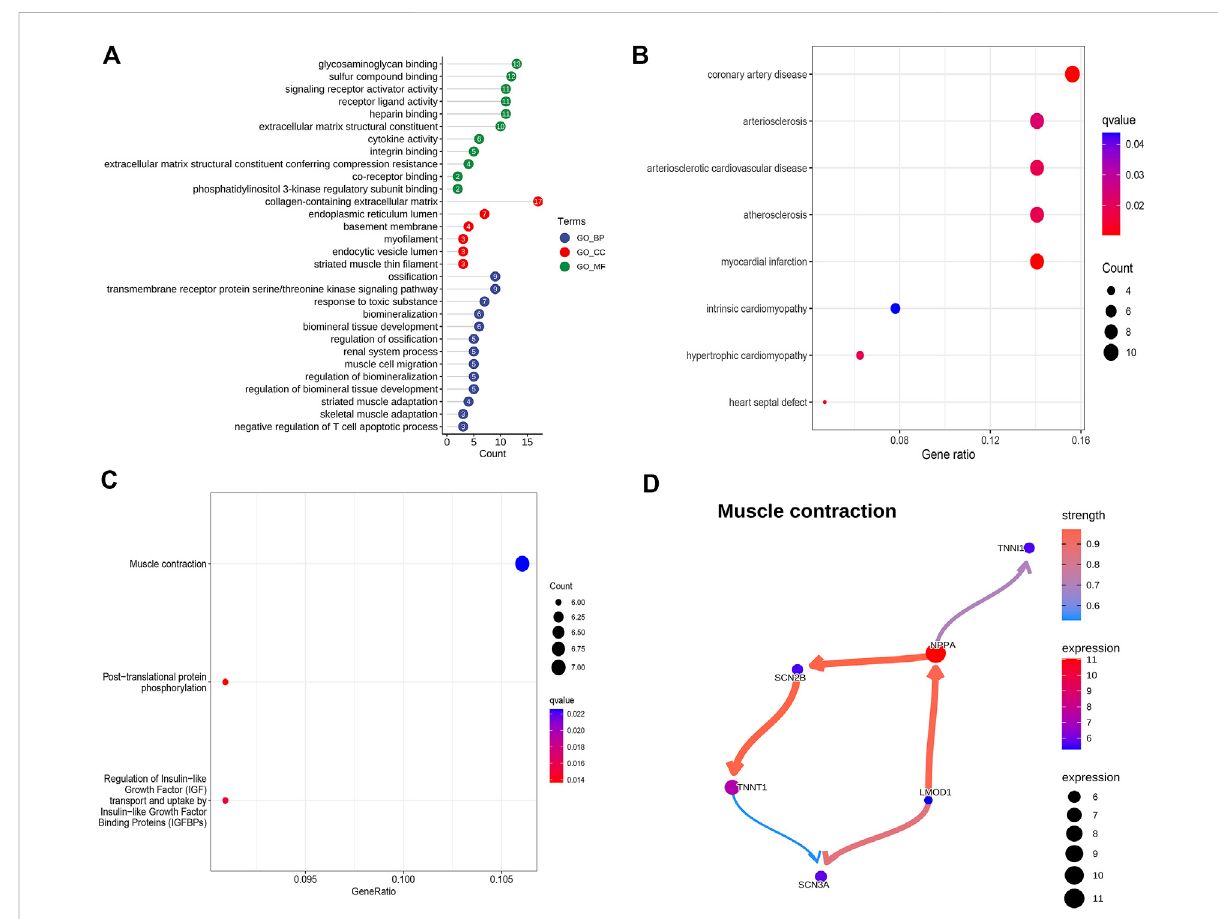
FIGURE 2 Potential biological function, pathways, and associated diseases of up-regulated DEGs. (A) GO enrichment analysis of up-regulated DEGs. (B) DO enrichment analysis of up-regulated DEGs. (C) KEGG enrichment analysis of up-regulated DEGs. (D) Bayesian network plot showing the regulatory relationships of genes in muscle